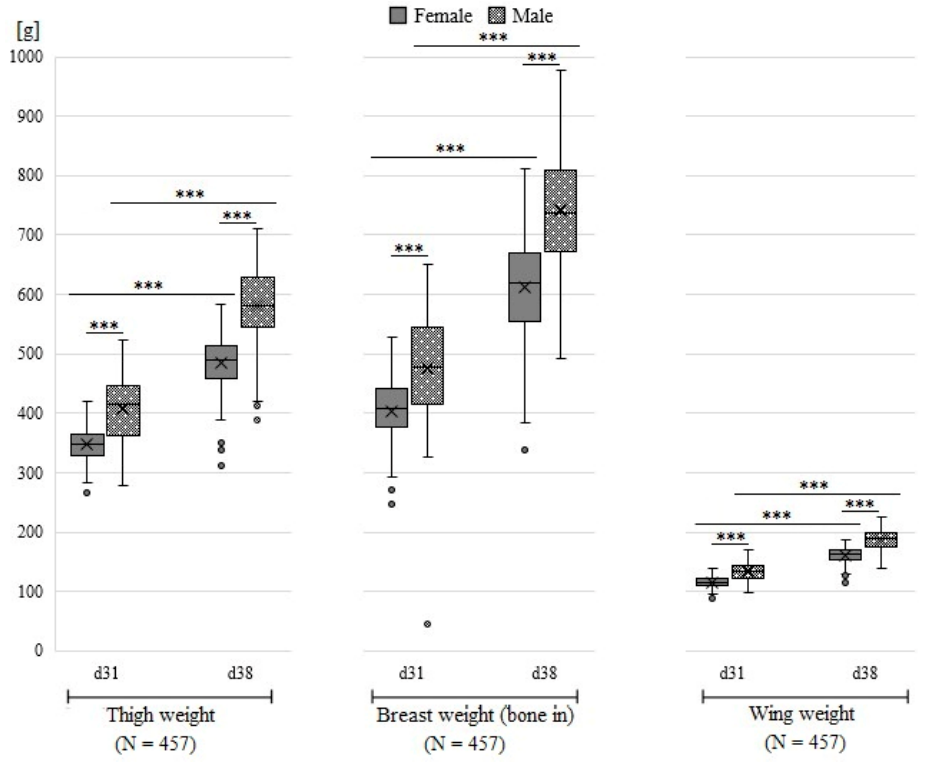
Figure 3. Effect of the interaction between sex (females presented in gray, males presented with patterns) and age at slaughter (day 31, day 38) on thigh, breast and wing weight. Results are presented as boxplots (data range, median, lower quartile, and upper quartile; outliers are included in the graph as dots); significant differences between sex and age are marked by asterisks: *** p < 0.001 (Tukey–Kramer tests).